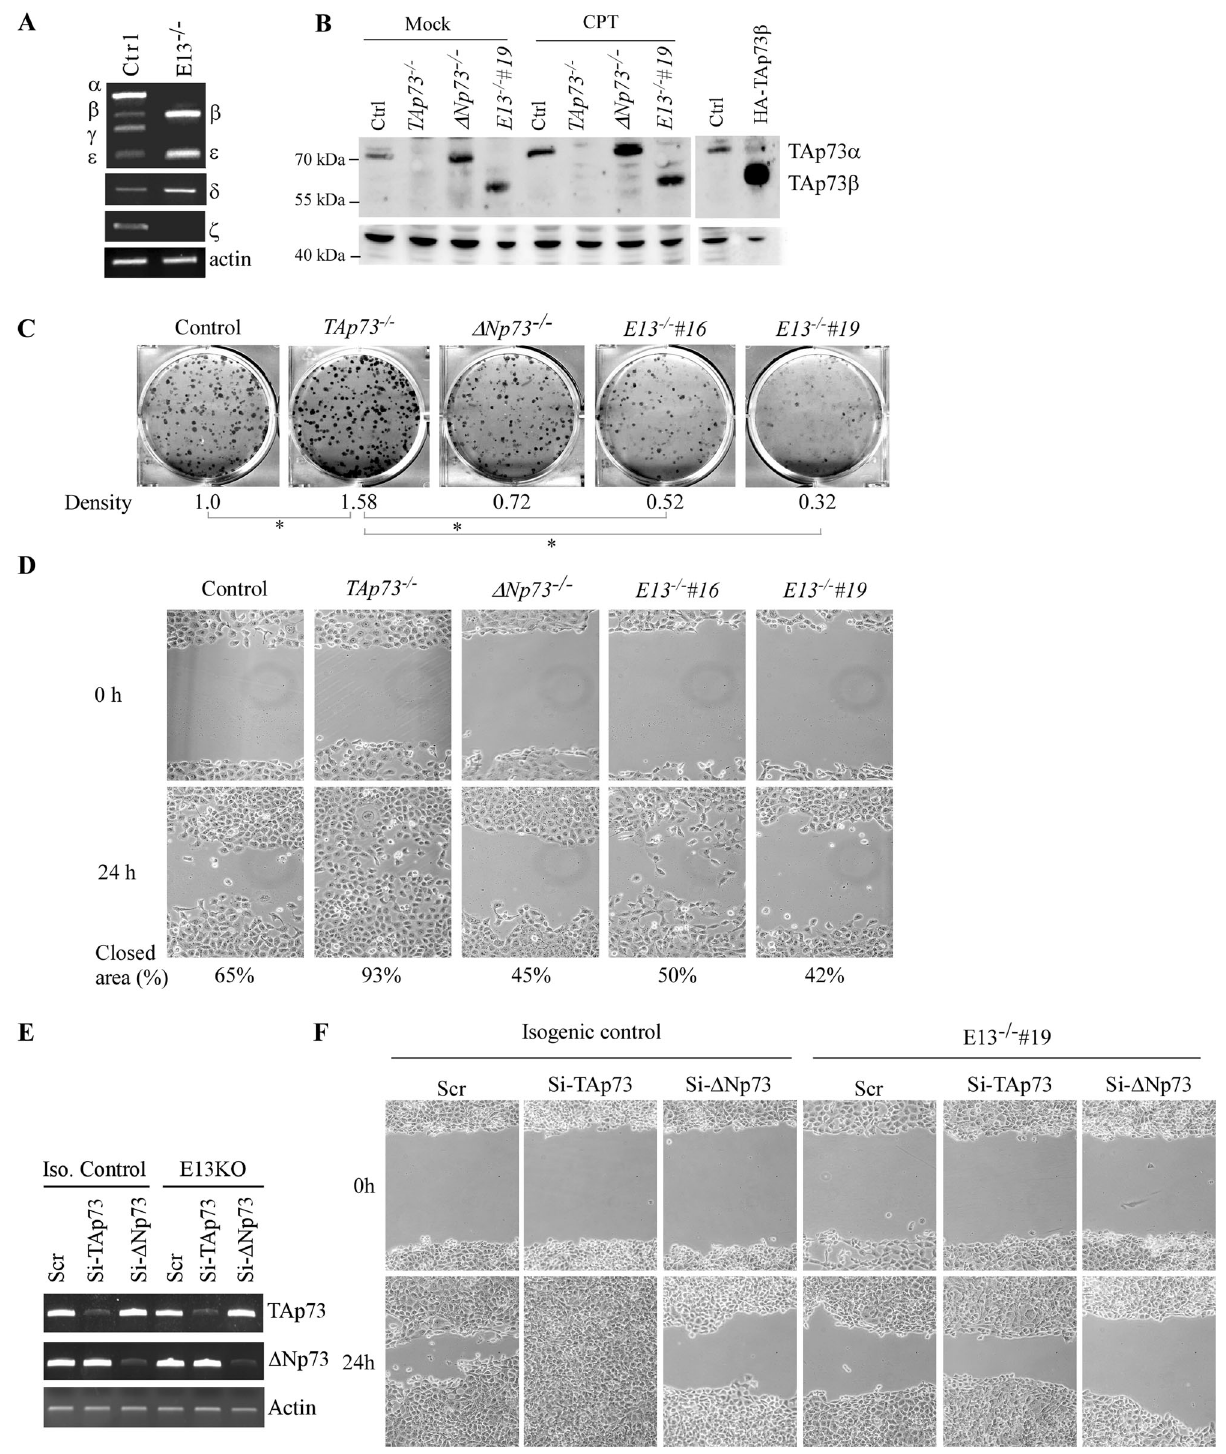
Fig. 1 Loss of E13 leads to increased expression of p73 β and subsequently, induces growth suppression and sensitizes cells to ferroptosis. A The level of various p73 isoforms and actin transcripts was measured in isogenic control and E13-KO H1299 cells. B The level of p73 and actin proteins was measured in isogenic control, TAp73-KO, Δ Np73-KO and E13-KO H1299 cells mock-treated or treated with camptothecin (CPT) for 18 h. The HA-tagged TAp73 β □□□□□□ n were used as a reference control for endogenous TAp73 β . C Colony formation assay was performed with isogenic control, TAp73-KO, Δ Np73-KO and E13-KO H1299 cells. The relative density was quanti fi ed and shown below each image. * p < 0.05 by Student ’ s t -test. D Scratch assay was performed with isogenic control, TAp73-KO, Δ Np73-KO and E13- KO H1299 cells. The relative % of wound closure was shown below each image. E Isogenic control and E13-KO H1299 cells were transiently transfected with a scrambled siRNA or a siRNA against TAp73 or Δ Np73, followed by RT-PCR to measure the level of TAp73, Δ Np73 and actin transcripts. F Scratch assay was performed with cells treated in